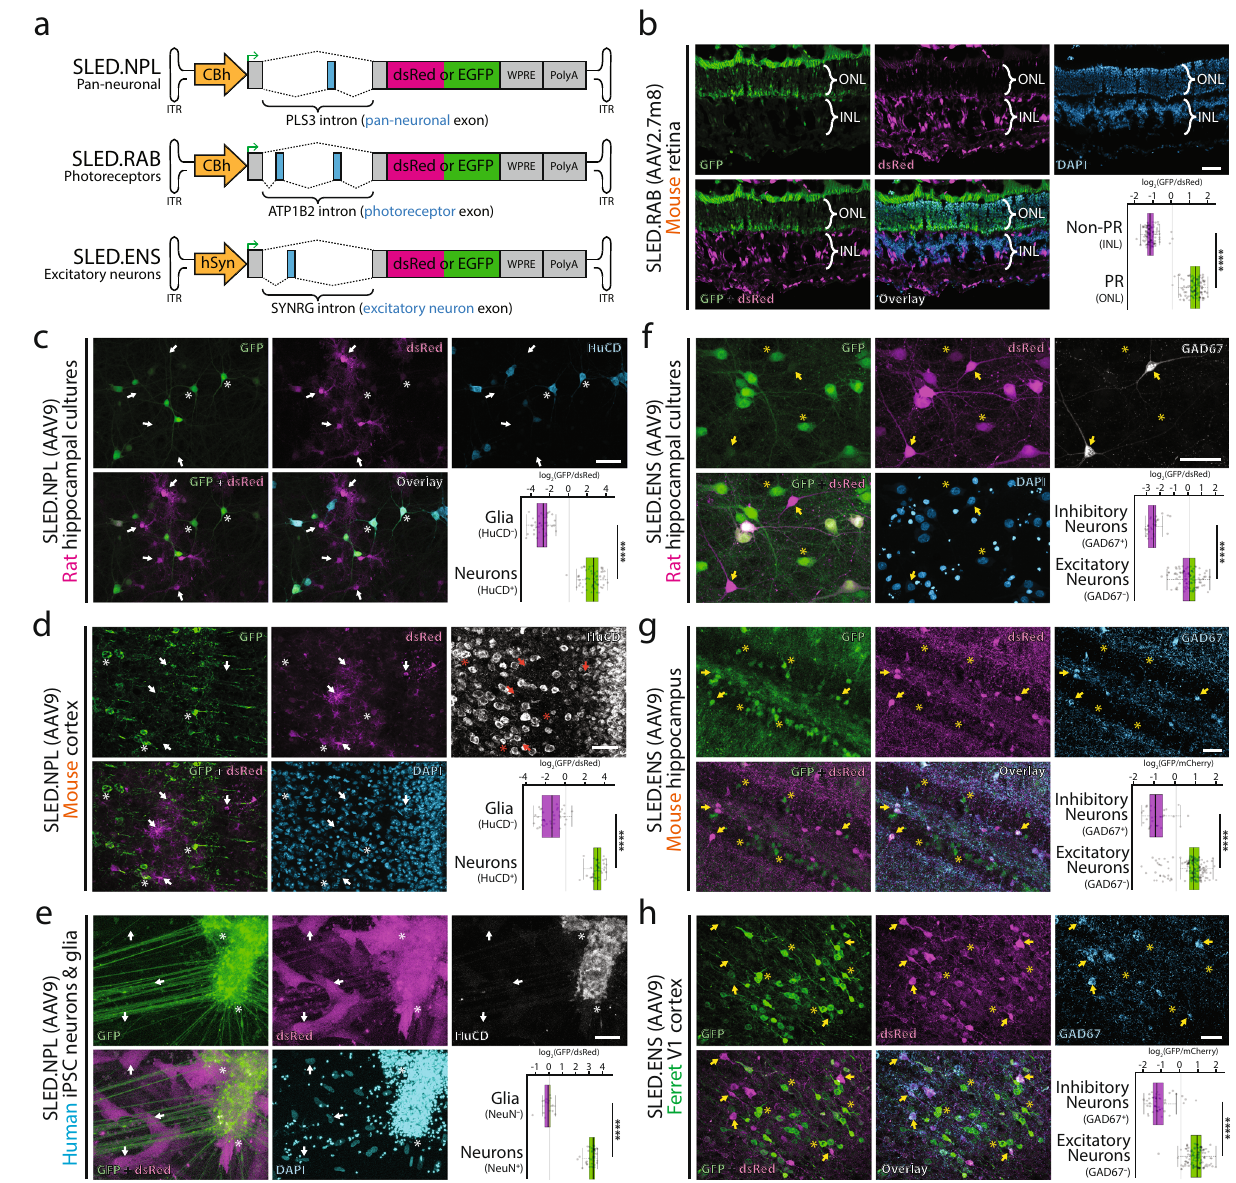
Fig. 2 | SLED vectors maintain cell-speci fi c expression when delivered using AAV. a Diagramatic sketch of pan-neuronal (SLED.NPL), photoreceptor-speci fi c (SLED.RAB), and excitatory neuron-speci fi c (SLED.ENS) vectors designed for AAV packaging. In all SLED vectors, EGFP is translated when cell-speci fi c exons are spliced-in. b SLED.RAB, packaged in AAV2.7m8, was intravitreally injected into P0 mouse retinas and processed at P30. EGFP is highly enriched in retinal photo- receptors while inner retinal neurons are strongly positive for DsRed. ONL=outer nuclearlayer,INL=innernuclear layer. c – e SLED.NPL, packaged inAAV9,was used to transduce primary rat hippocampal cultures ( c ), mouse cortex ( d ), and human iPSC-derived neurons ( e ). In all cases, EGFP is highly enriched in HuC/D + (rat, mouse) or NeuN + (human) neurons, while non-neuronal cells are strongly positive